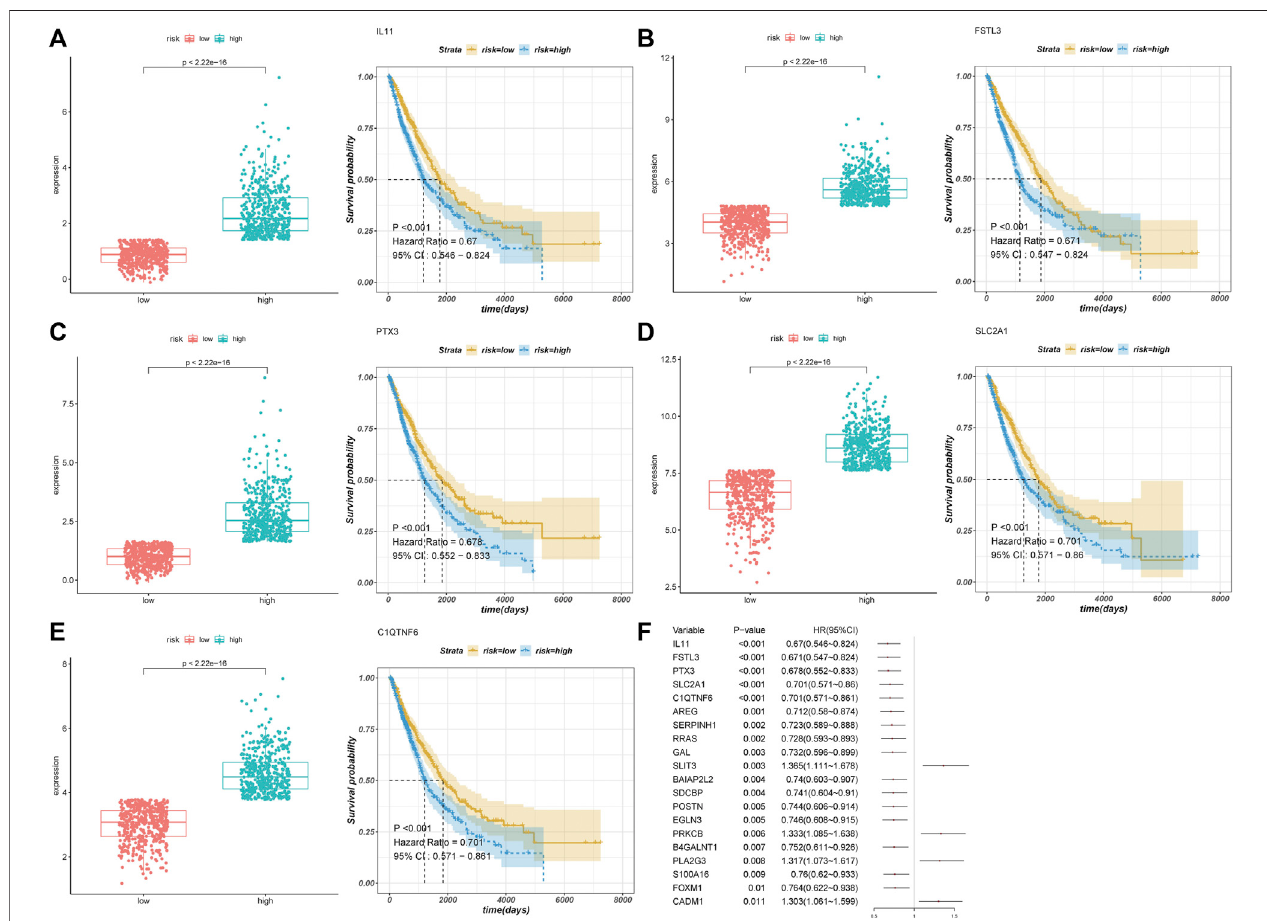
FIGURE 3 | Univariate Cox regression analysis. (A – E) Top fi ve prognostic genes. (F) Forest plot of the top 20